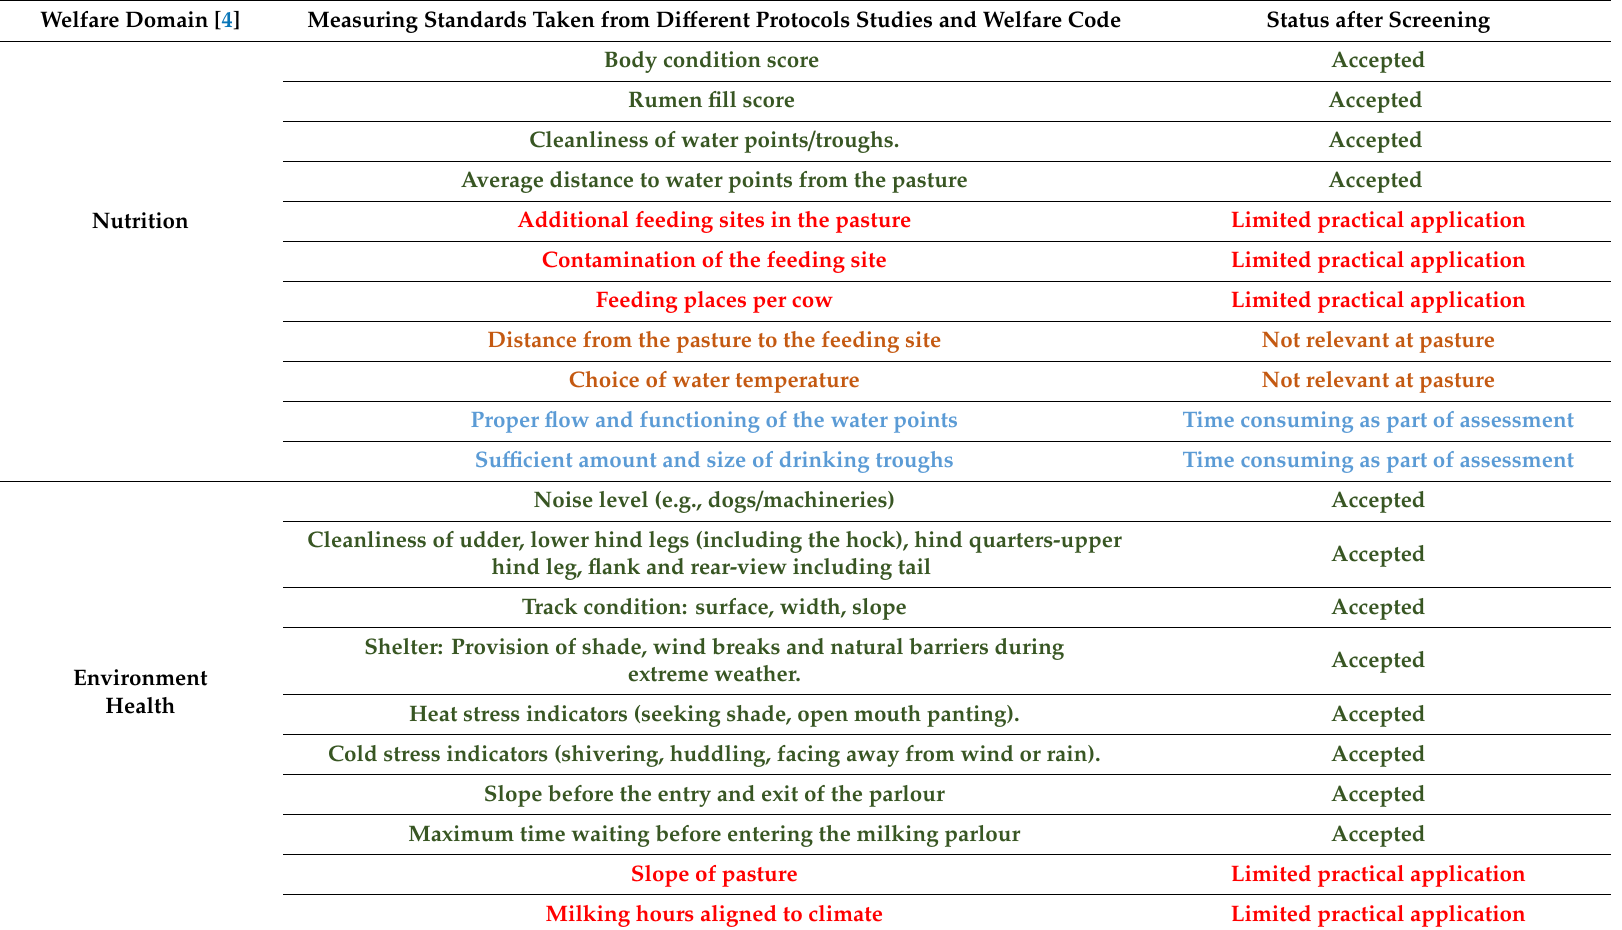
Table A1. Welfare Assessments Identified during Phase I and Status after